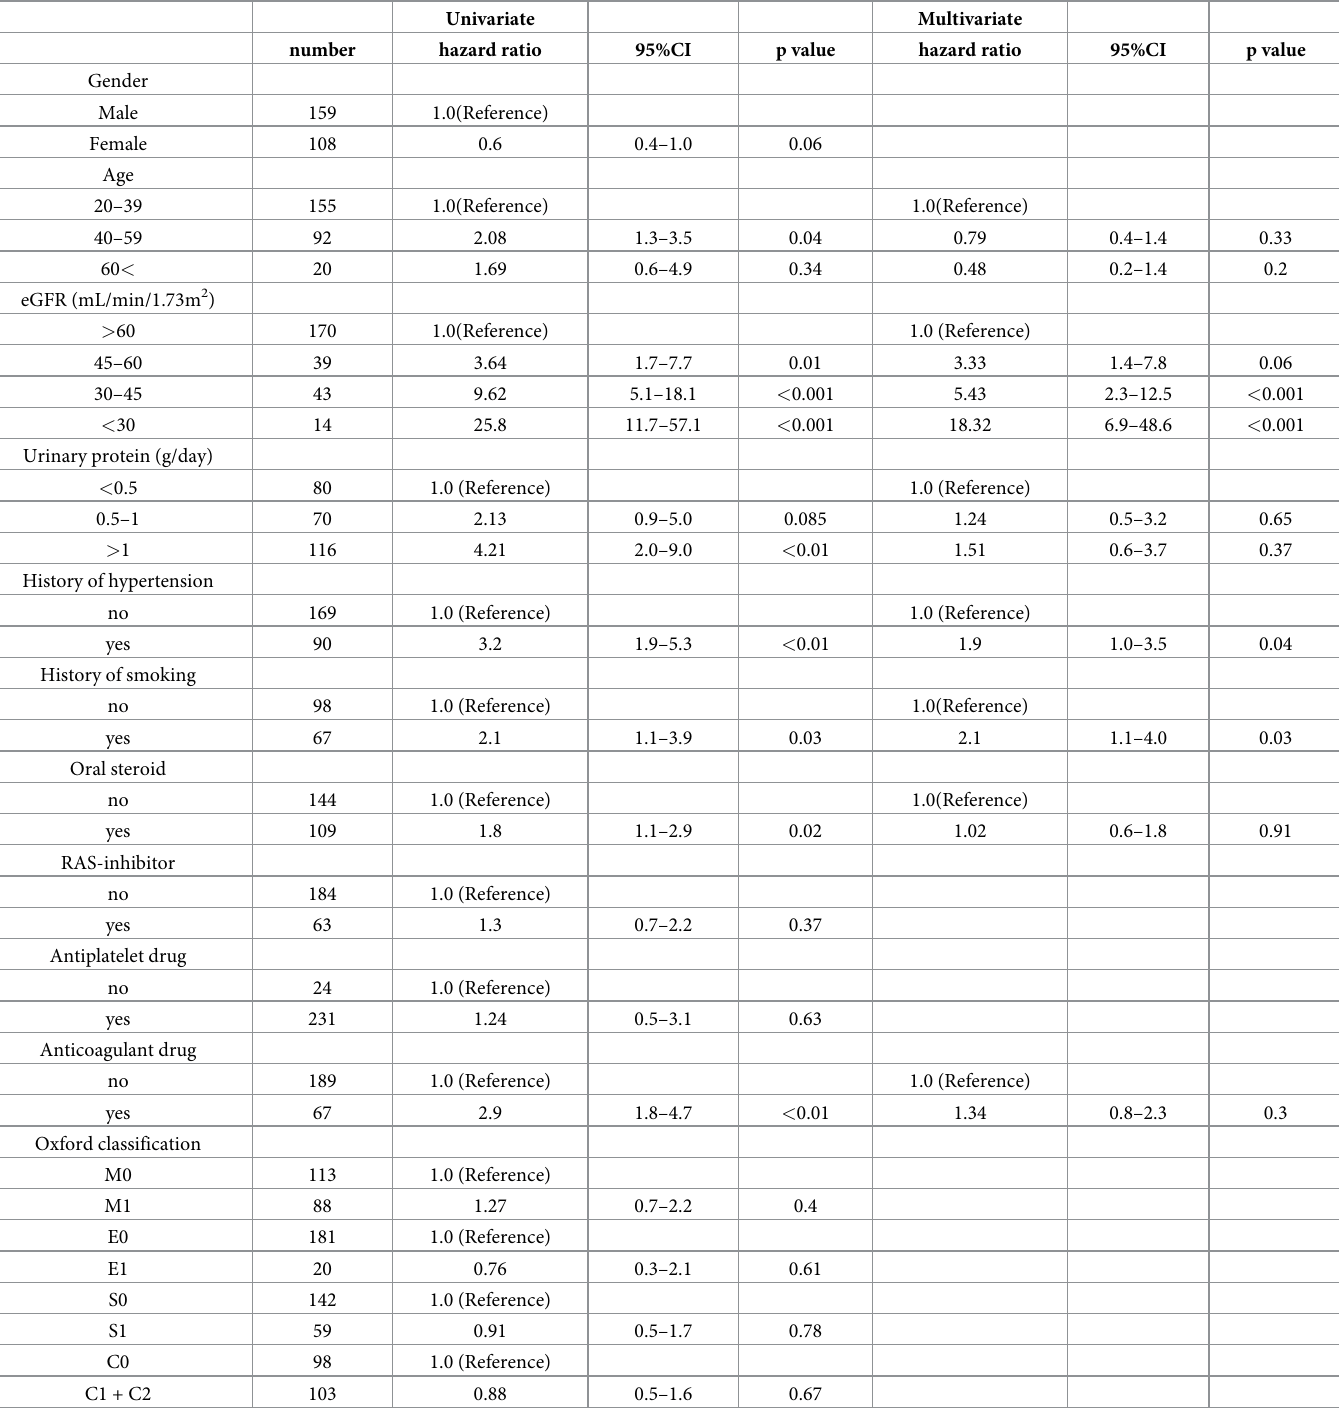
Table 3. Univariate and multivariate COX regression analyses for renal